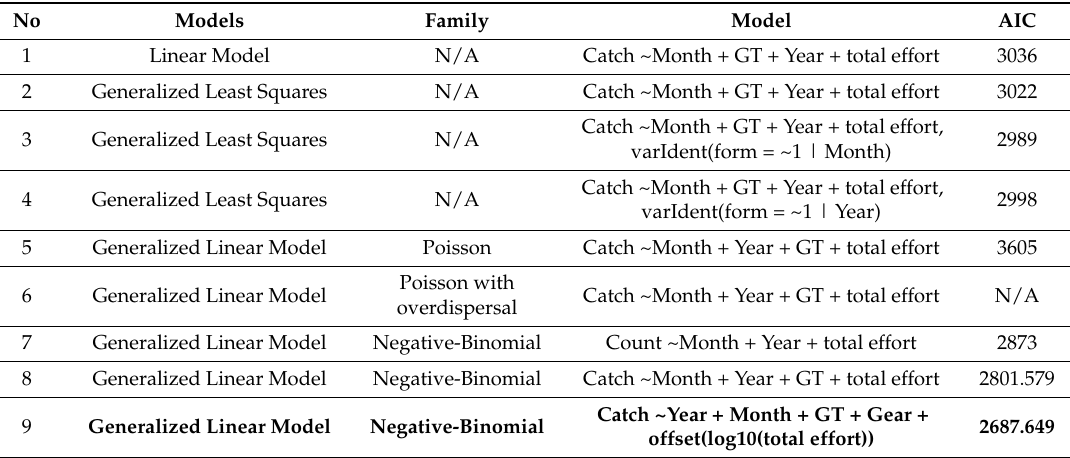
Table 3. Candidate model set tested to identify important explanatory variables for the silky shark catch-per-unit-effort (CPUE). The best-fitted model is highlighted in bold. The best fitted model in the generalized linear model negative binomial (GLM NB) equation (Equation (1)) is further used for the binomial model (Equation